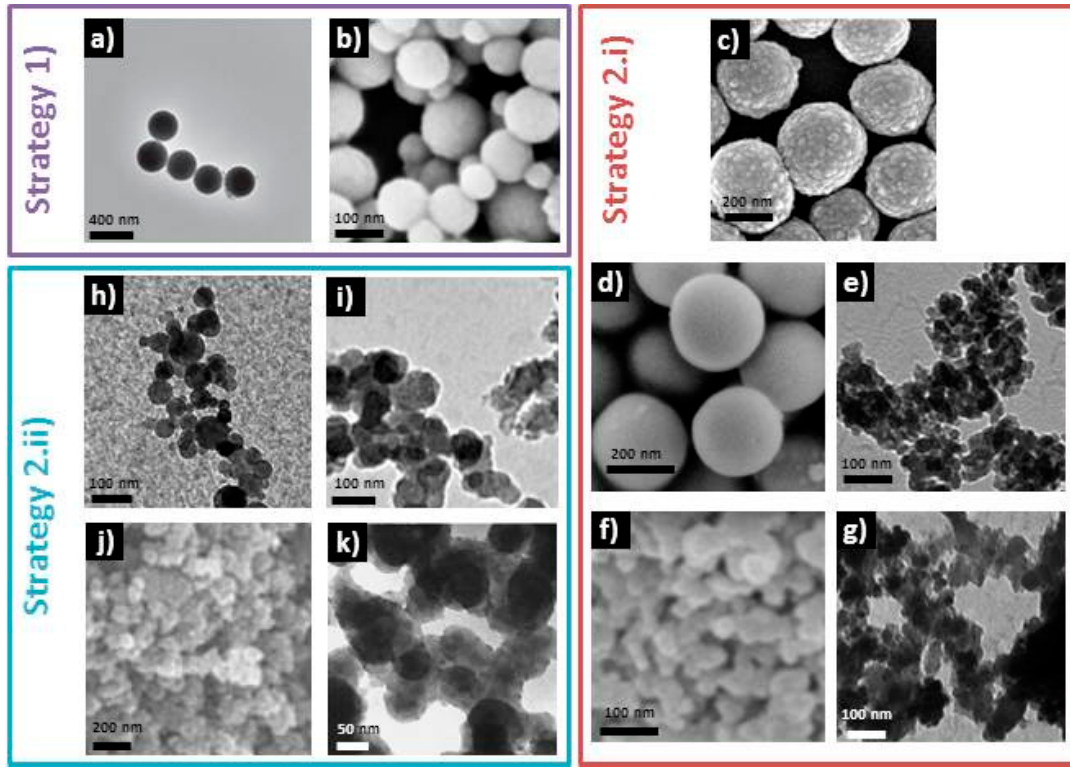
Figure 2. Selection of TEM or SEM images of bioactive glass nanoparticles synthesized by different groups. Adapted with permission from [14] ( a ); [16] ( c ); [17] ( g ), ©Wiley; [18] ( e ); [20] ( h ); [21] ( i );